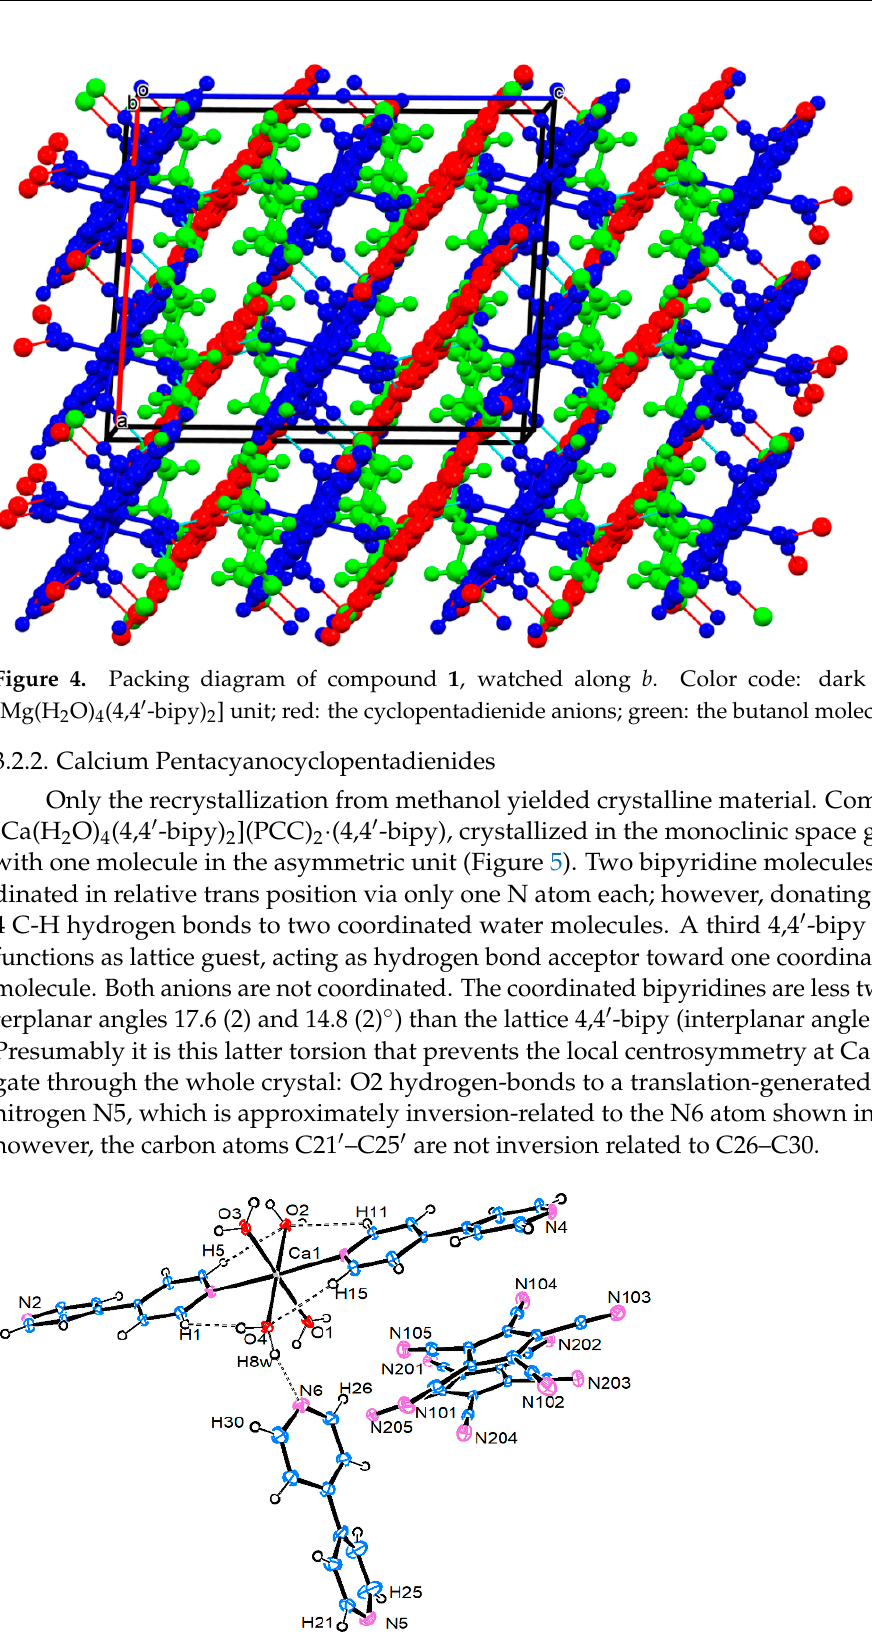
Table 1 . Important bond lengths [Å] and angles [°] of compounds 1 and 2 .